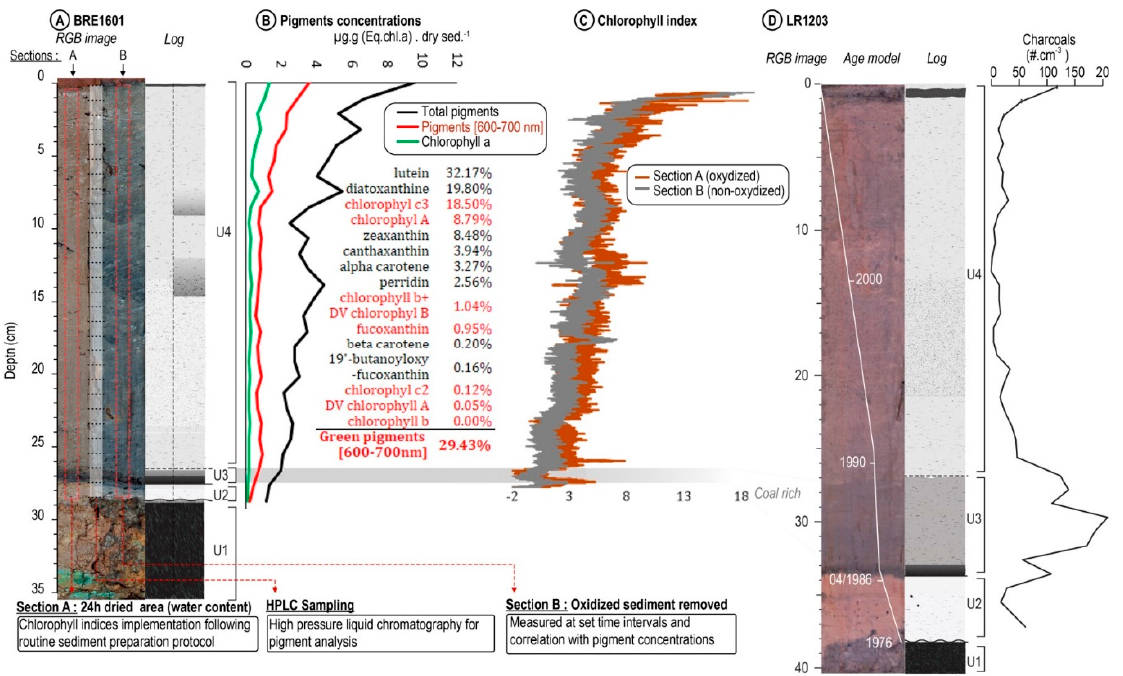
Figure 2. ( A ) Presentation of the BRE1601 archive with the areas concerned by the two protocols. The left section of the archive corresponds to the routinely used protocol (section ( A ), oxidized), the center was sampled for the HPLC analysis and the cross section is used to compare the indices before oxidation (section ( B ), unoxidized). ( B ) In-depth profiles of chlorophyll-a, chlorophyll pigments and total pigments. The average value of the 22 pigments concentrations is presented, and the chlorophyllin pigments whose reflectance is between 600 and 700 nm are given in red. ( C ) The sampling of the analysis is presented on the profile in total pigments. The Area T 650–700 index is presented before and after oxidation. ( D ) Comparison with the LR1203 archive and the profile of macroscopic coals particles [15].